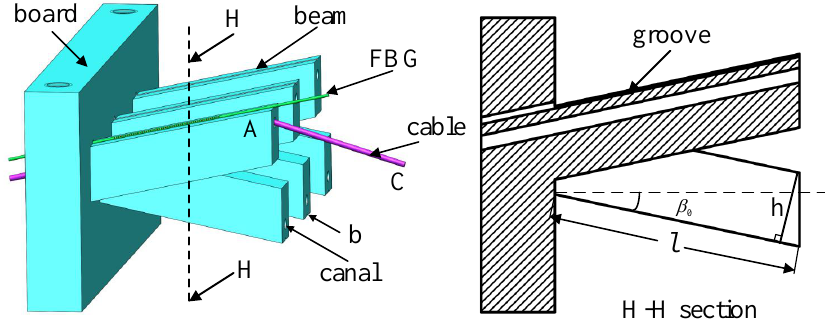
Figure 3. The structure of proposed sensor applied to measure cable tension in surgical robot.